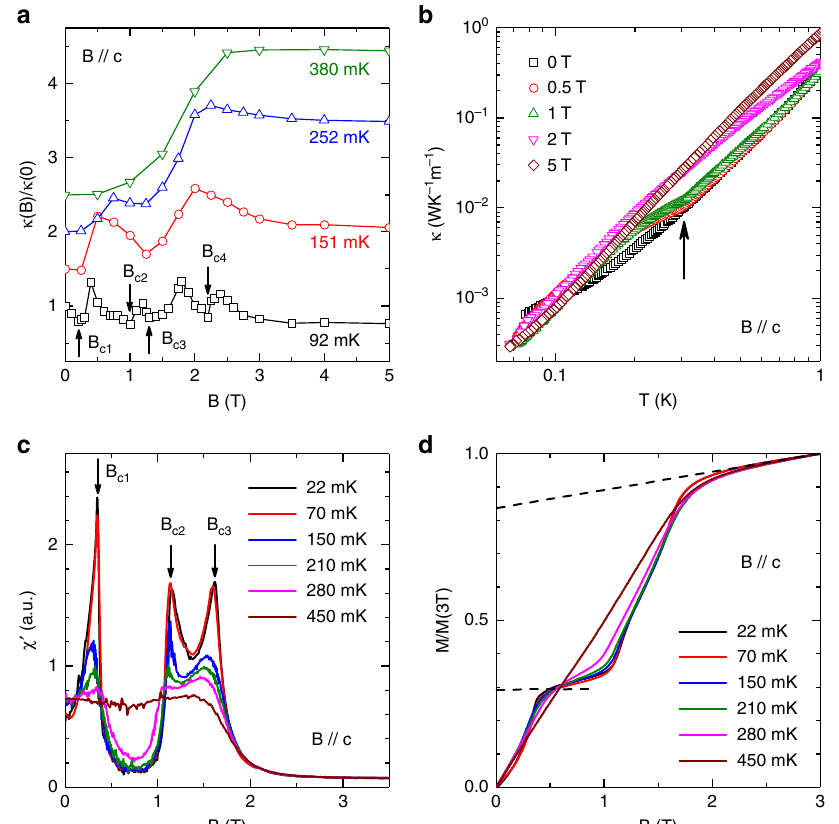
Fig. 4 Thermal conductivity and AC susceptibility of Na 2 BaCo(PO 4 ) 2 for B // c . a Magnetic- fi eld dependence of thermal conductivity at different temperatures. For clarifying, the 151 mK, 252 mK and 380 mK curves are shifted upward by 0.5, 1.0 and 1.5, respectively. At 92 mK, there are four minima indicated by arrows. With increasing temperature, the minima become weaker and disappear above 380 mK. b Temperature dependence of κ in different fi elds. At low fi elds of 0.5 and 1 T, there is a clear slope change of κ ( T ) curves around 310 mK, which has good correspondence to the speci fi c-heat anomaly. c AC magnetic susceptibility at different temperatures. There are three peaks in the low-temperature curves. d Magnetization curves obtained by integrating the AC susceptibility data and renormalized with the 3 T value. The lower dashed line indicates a ~1/3 plateau and the upper dashed line indicates the Van Vleck paramagnetic